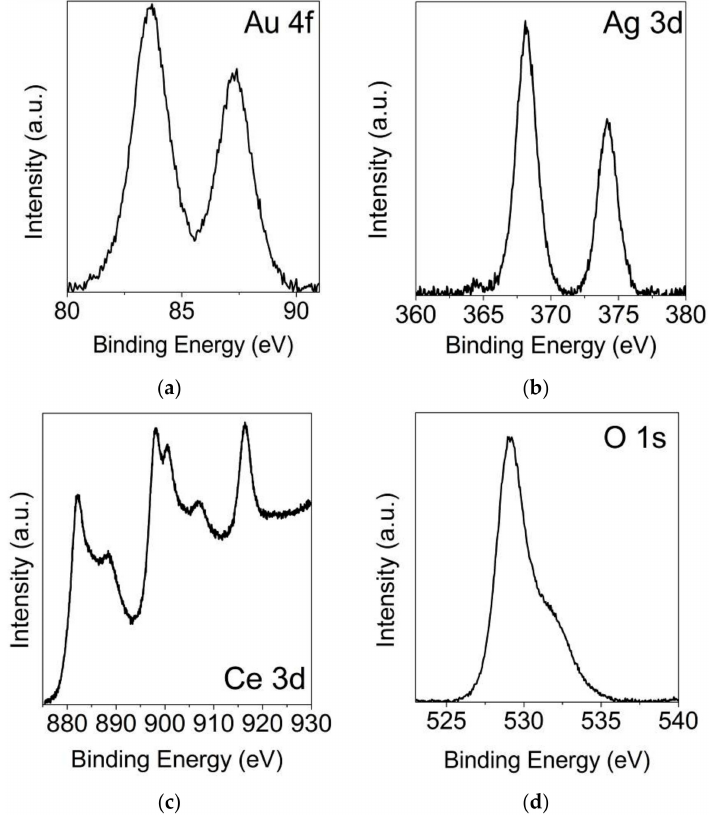
Figure 6. Al-K α excited X-ray Photoelectron Spectroscopy of the AuAg / CeO 2 sample in the Au 4f binding energy region ( a ), in the Ag 3d binding energy region ( b ), in the Ce 3d binding energy region ( c ) and in O 1s binding energy region ( d